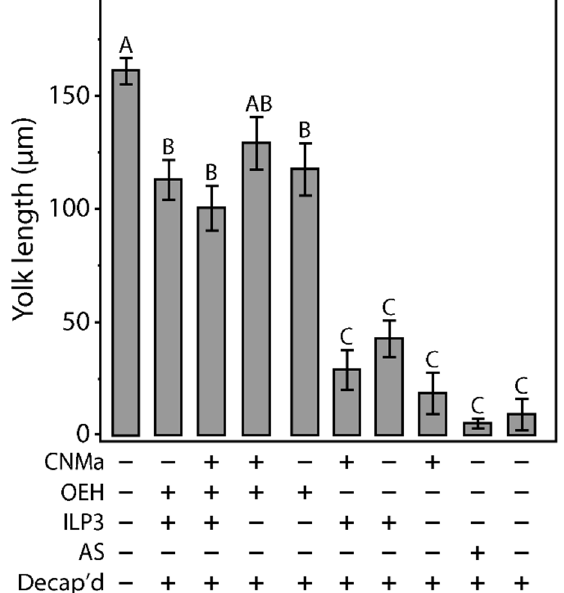
Figure 6. Injection of CNMa along with ILP3 or OEH does not have a significant effect on yolk uptake in decapitated females. Average amount of yolk per oocyte in mated, blood fed, decapitated females injected with combinations of CNMa (150 pmol), ILP3 (20 pmol), and OEH (20 pmol), Aedes saline (AS), or not injected (intact or decapitation only) at one-hour post blood meal. Error bars show one standard error above and below the mean. Yolk uptake in the CNMa only treatment was not significantly different from decapitated only and AS control treatments. There was no significant difference in yolk uptake in CNMa + OEH + ILP3 injected females compared to ILP3 + OEH injected females. Decapitated females injected with OEH + CNMa demonstrated no significant difference in yolk uptake relative to OEH only or OEH + ILP3 treatments. There was no significant difference in yolk uptake among ILP3 and OEH, ILP3 only, and CNMa and ILP3 treatments. Bars not connected by the same letter are statistically significantly different, p < 0.05, Tukey’s HSD.